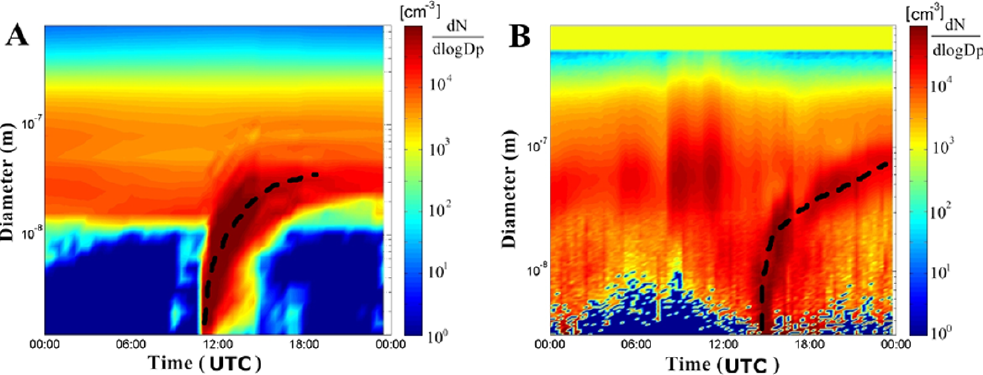
Fig. 2. Sample new particle formation events in the model with ternary nucleation (10 − 5 tuning factor) and measurements at Pittsburgh. Con- tours represent values of the size distribution function plotted against particle diameter in m (ordinate) and time in UTC (abscissa). Dashed line represents the diameter growth trajectory ( A ) Pittsburgh, PA, USA, modeled 16 April 2002 ( B ) Pittsburgh, measured, 16 April